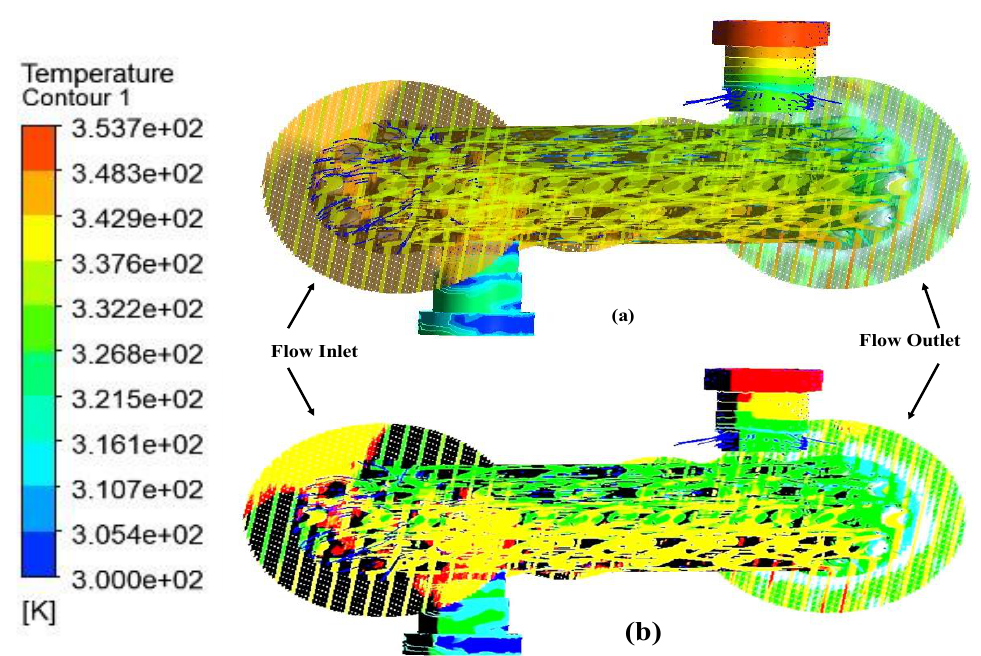
Figure 8. Pressure contours at cross-sections of ( a ) round tubes and ( b ) hexagonal tubes of a heat exchanger at 100 mm, 250 mm, and 450 mm.